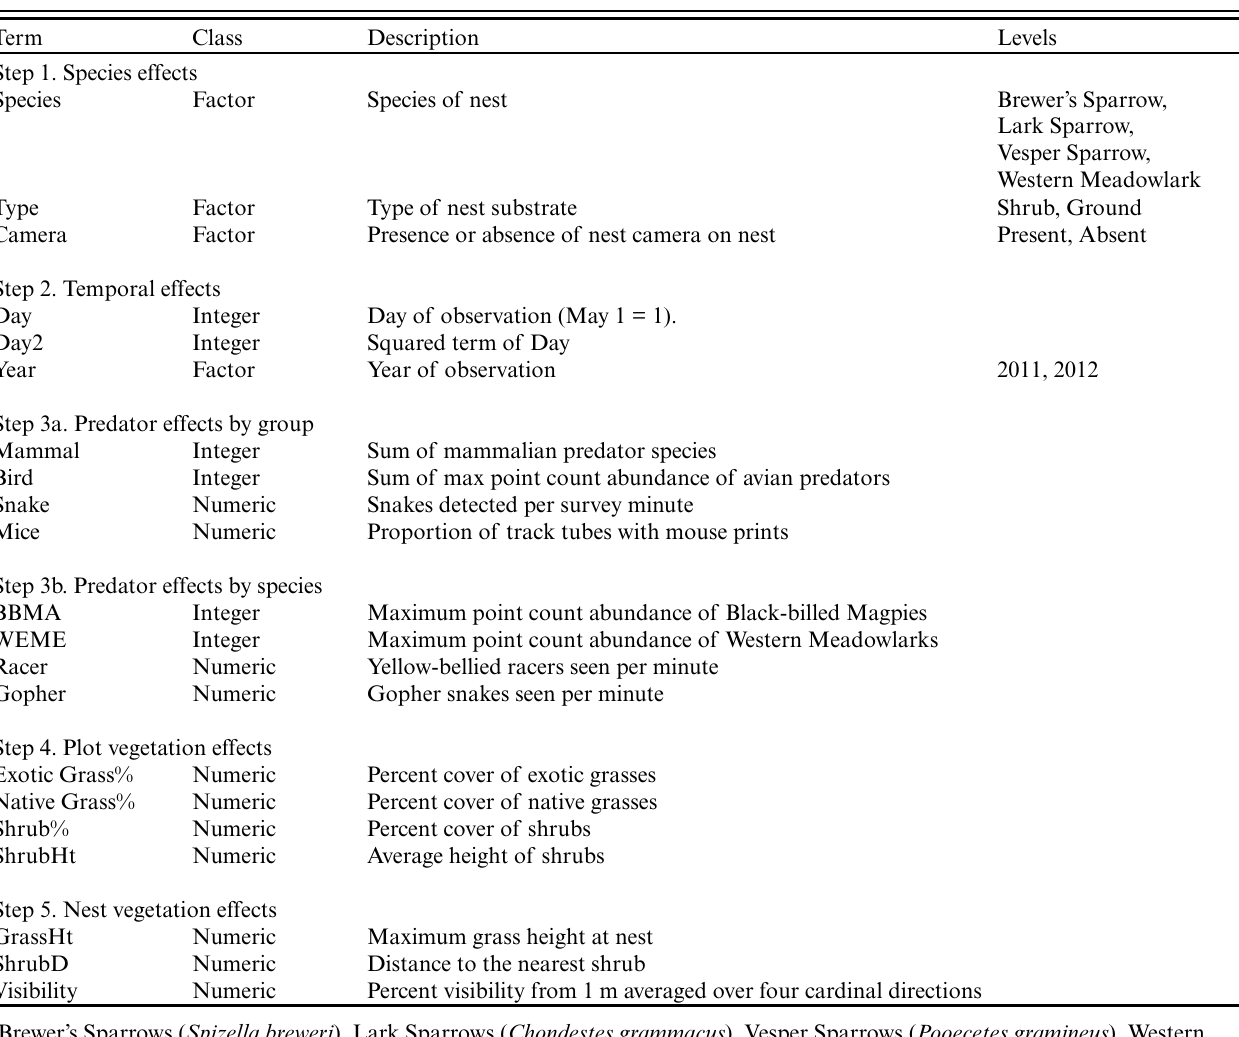
Table 1 . Terms considered to explain predation-specific daily nest survival rate (PDSR) and nestling condition of songbirds in sagebrush habitat. Terms were selected in a multistep hierarchical process using an information theoretic